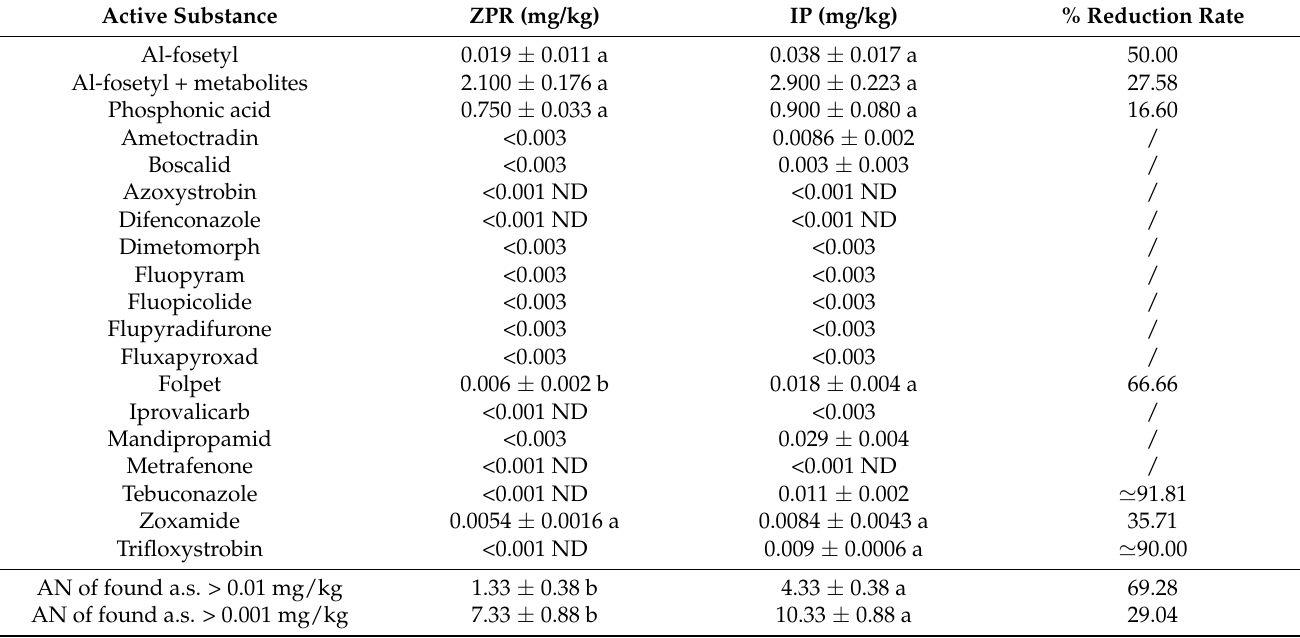
Table 10. Average concentration (mean ± SE) of pesticide residues in Sauvignon grapes. A result of <0.001 ND means that a.s. was not detected at a level higher than 0.001 mg kg − 1 . /—concentration reduction rate and significance of difference between IP (integrated) and ZPR (0-pesticide residue) means cannot be calculated. Pesticide concentration reduction rate (%) = 100 − ((ZPR/IP) × 100) (see explanation in Section